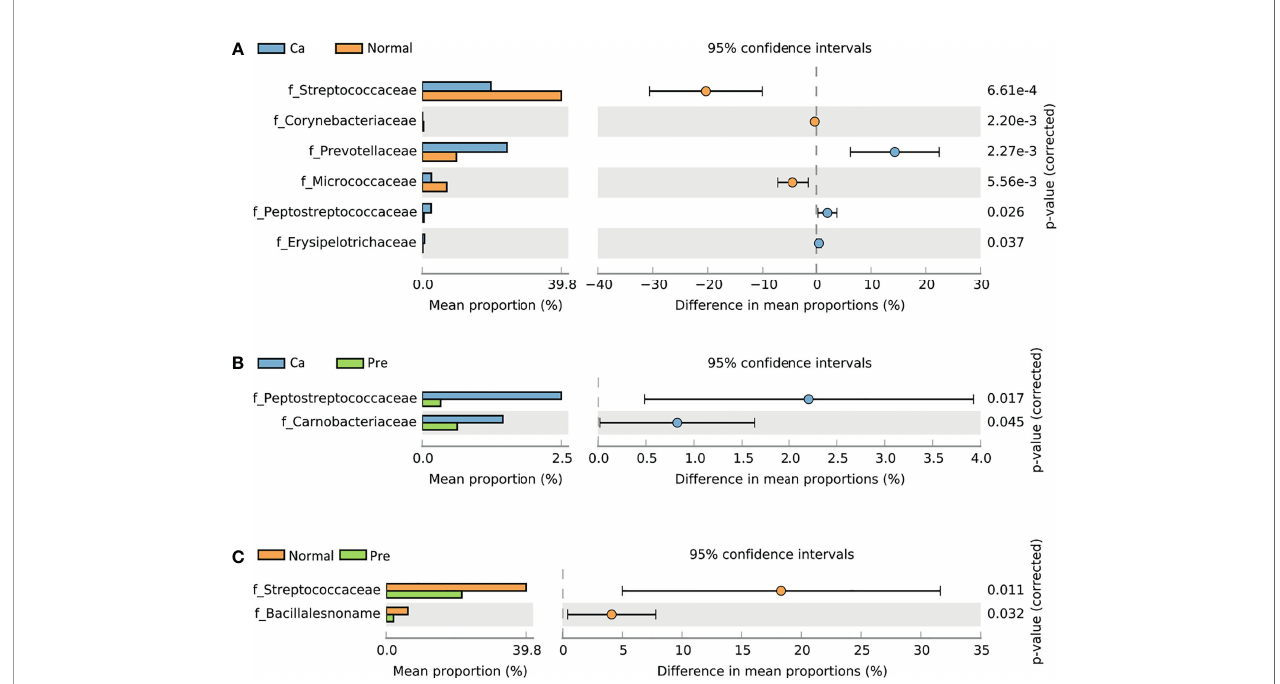
FIGURE 1 | Comparative taxonomic pro fi les of the three groups at the family level showed signi fi cant differences in richness between two groups (P < 0.05, calculated using STAMP). (A) Difference between the oral cancer group and normal group. (B) Difference between the oral cancer group and precancerous lesion group. (C) Difference between the normal group and precancerous lesion